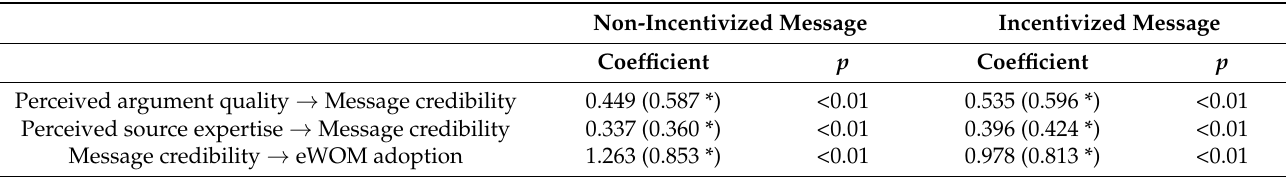
Table 9. Path coefficients for each group (message